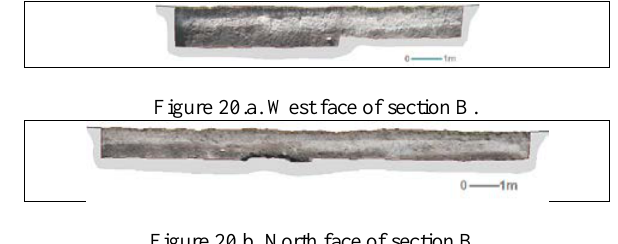
Figure 20.b. North face of section B.